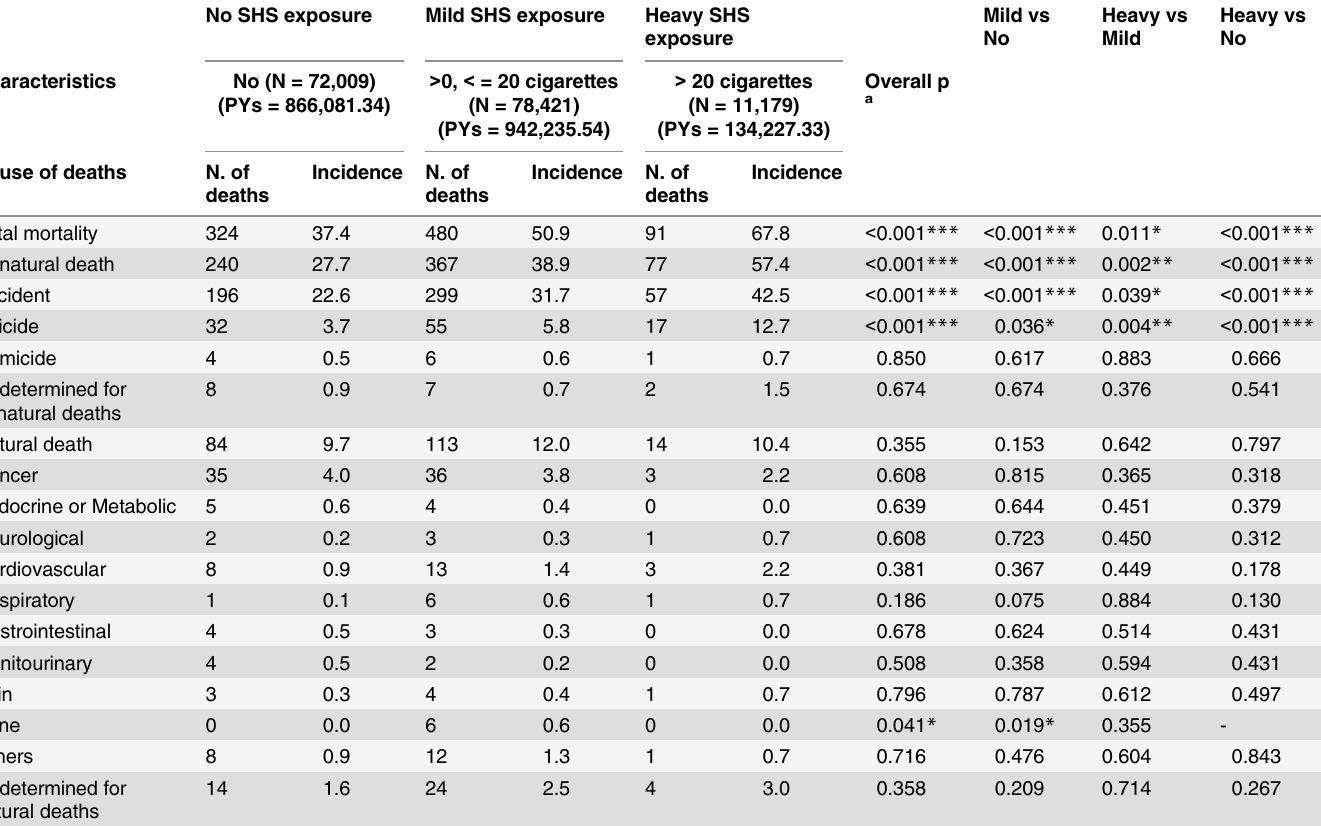
Table 3. Incidence rates of causes of death among the subjects stratified by the status of second hand smoking (SHS) (N =